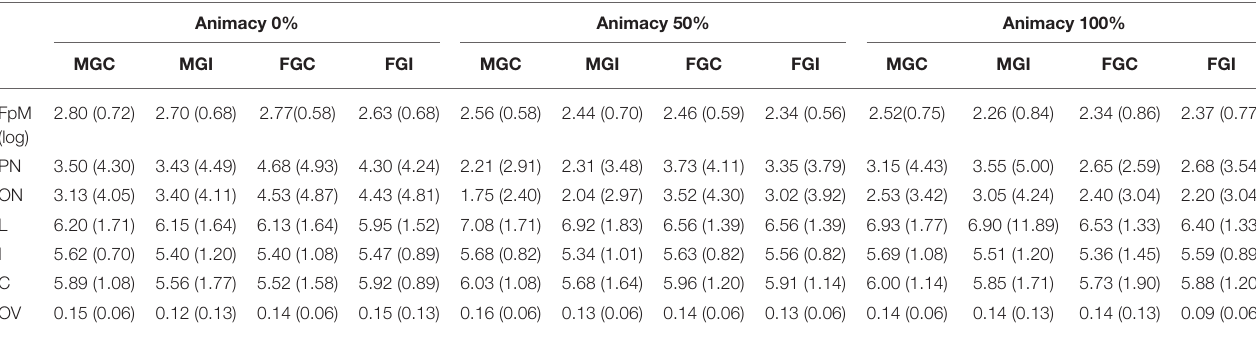
TABLE 3 | Mean and standard deviations (in parenthesis) of the controlled variables for the distractors across conditions of target gender and gender congruency within every condition of animacy presence in Experiment